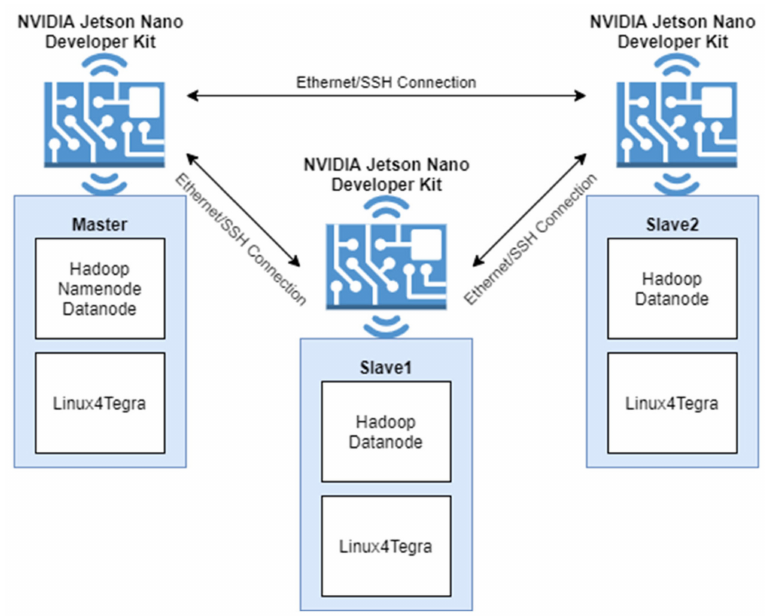
Figure 7. Multi-node SBC cluster architecture.